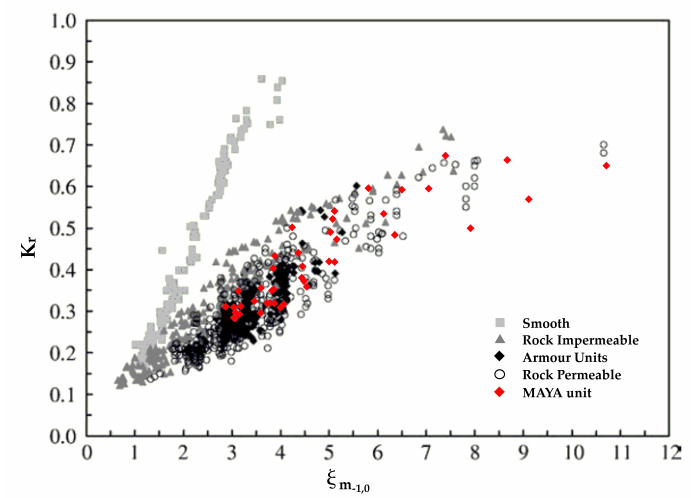
Figure 6. Experimental data included in the wave reflection database exploited by Zanuttigh and Van der Meer. Maya units are identified by red diamonds (adapted from